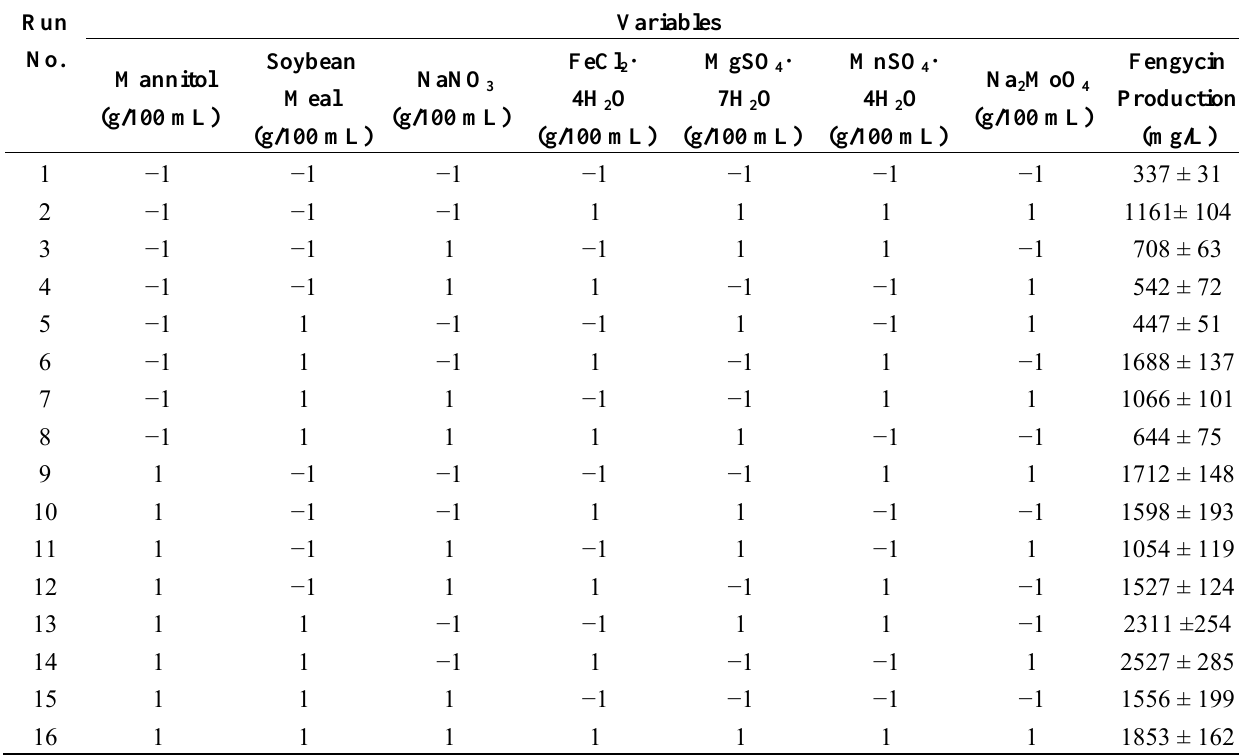
Table 2. Fractional factorial design for screening important variables that affect fengycin production ( n = 3).